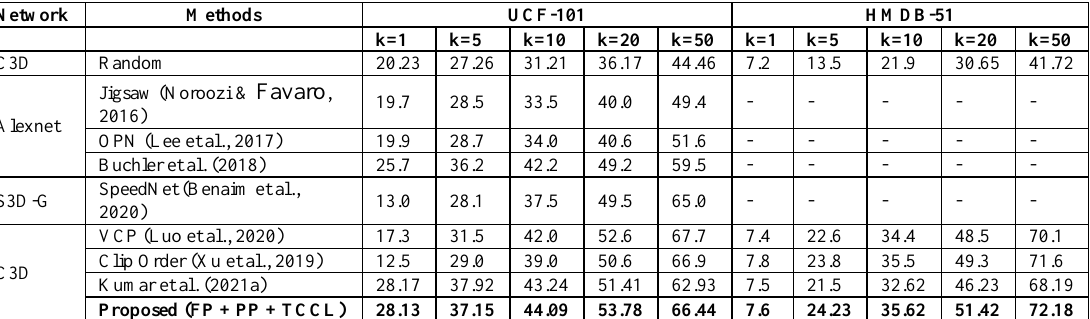
Table 5. (Clip Level) Top-k retrieval accuracy